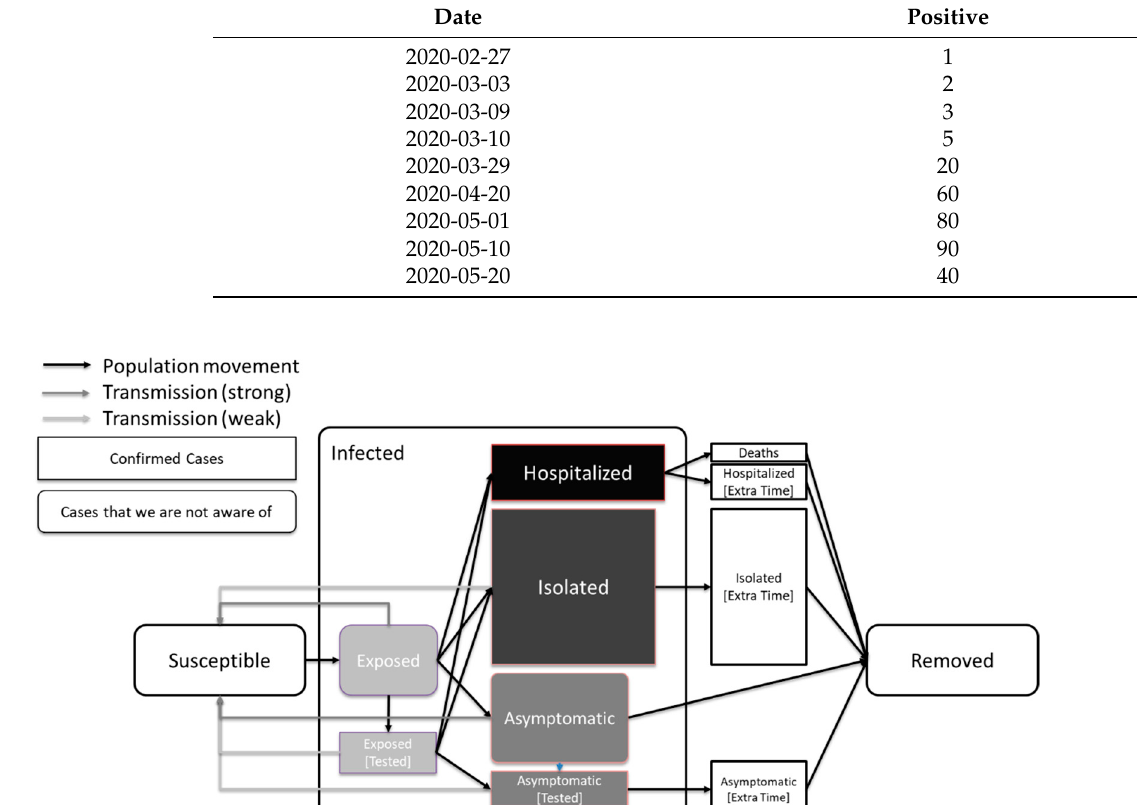
Figure 1. Model definition. The most infectious compartments are those of the Exposed and Asymptomatic carriers. Less infectious compartments are those of Isolated and tested people due to subsequent isolation. In this graph we also show that the average time of a person in the Exposed compartment is less than the average time of a person in the Asymptomatic compartment, which is in turn less than the average time of a person in the Isolated or Hospitalized compartments [9].